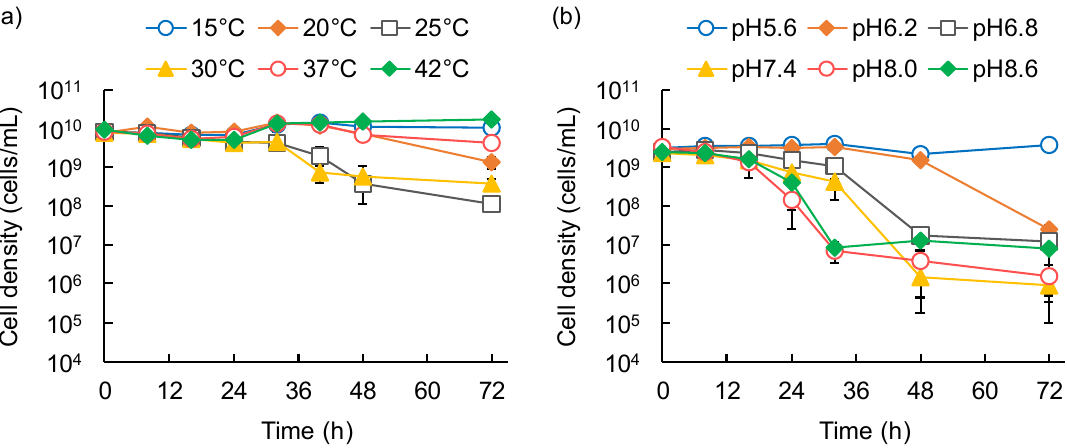
Figure 5. Effects of temperature ( a ) and pH ( b ) on Myxococcus sp. MH1 predation on Escherichia coli HB101. Temporal variations of HB101 cell density were monitored. Error bars represent standard deviation ( n = 3, except several data where n = 2).